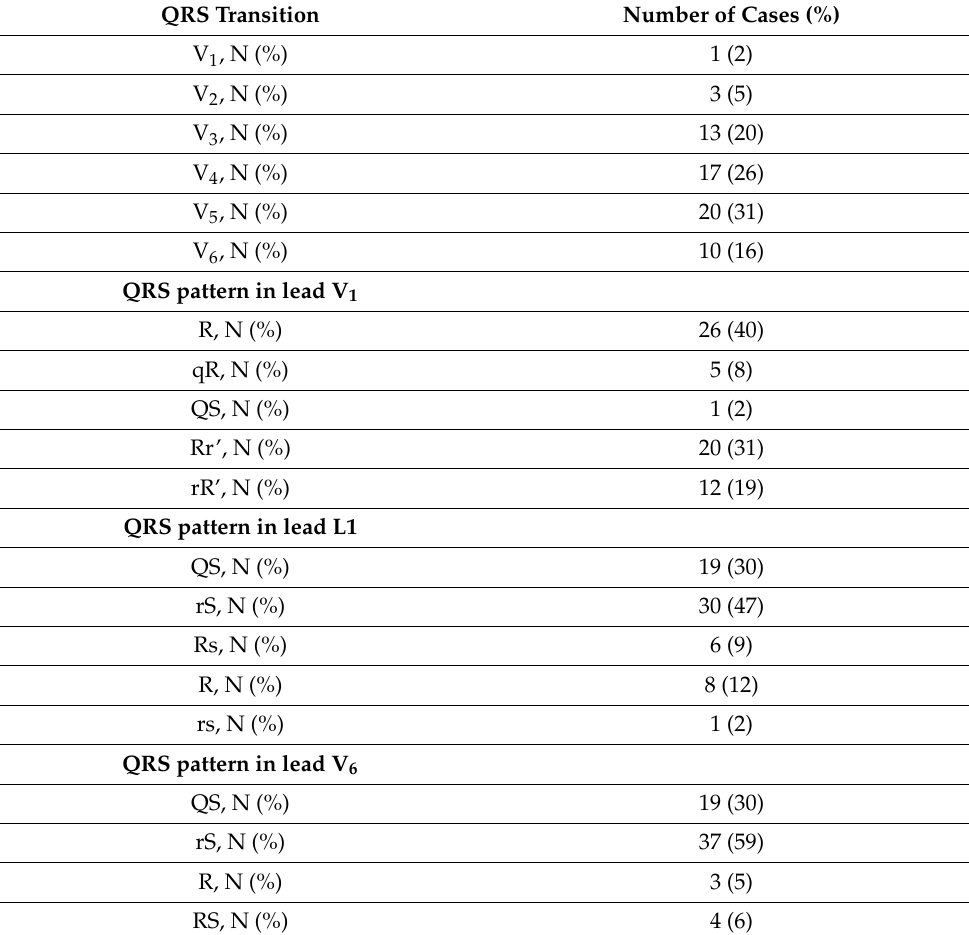
Table 3. Electrocardiographic